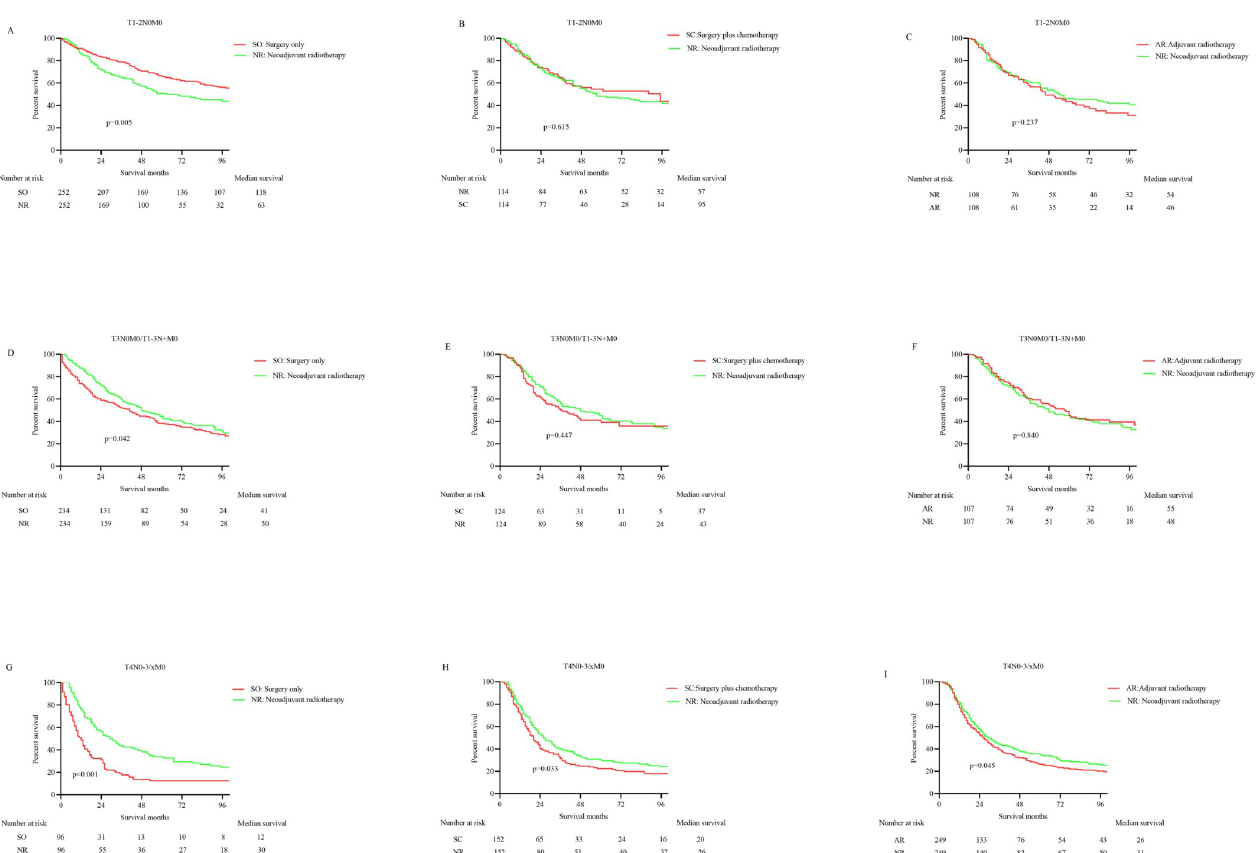
Fig 4. The K-M curves for OS in non- metastatic Siewert type II EGA patients at different stages after PSM. A. Surgery only vs Neoadjuvant radiotherapy in T1-2N0M0; B. Surgery combined with chemotherapy vs Neoadjuvant radiotherapy in T1-2N0M0; C. Neoadjuvant radiotherapy vs Adjuvant radiotherapy in T1-2N0M0; D. Surgery only vs Neoadjuvant radiotherapy in T3N0/T1-3N+M0; E. Surgery combined with chemotherapy vs Neoadjuvant radiotherapy in T3N0/T1-3N+M0; F. Neoadjuvant radiotherapy vs Adjuvant radiotherapy in T3N0/T1-3N+M0; G. Surgery only vs Neoadjuvant radiotherapy in T4; H. Surgery combined with chemotherapy vs Neoadjuvant radiotherapy in T4; I. Neoadjuvant radiotherapy vs Adjuvant radiotherapy in T4.